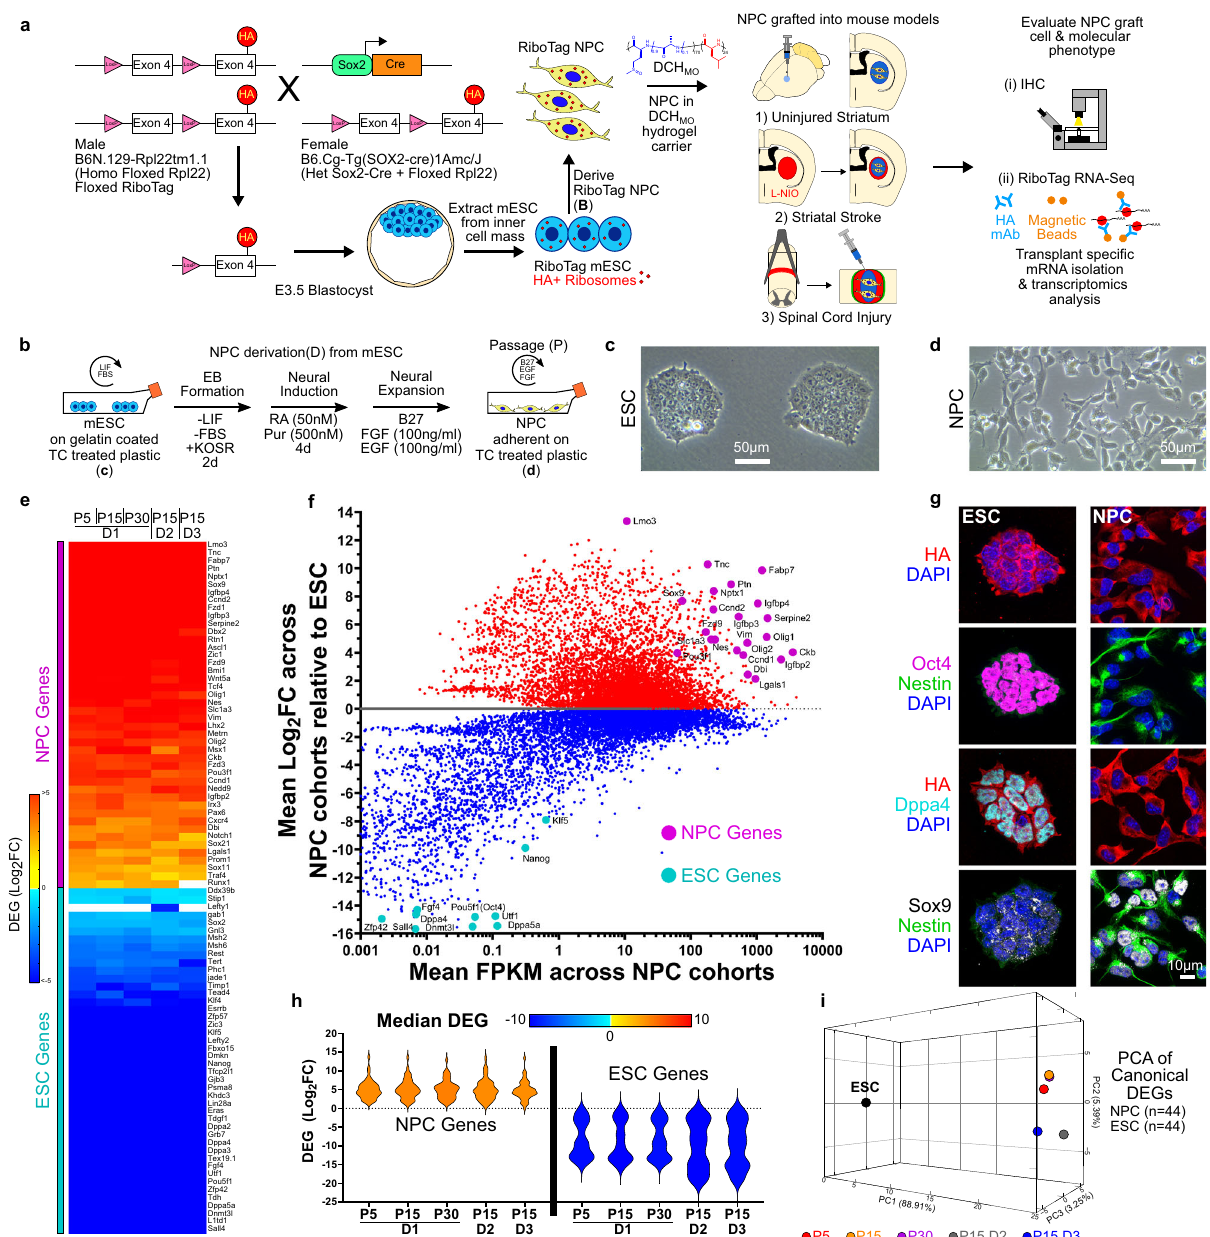
Fig. 1 | Neural induction and expansion ofRiboTag mESC derives reproducible and stable NPC lines. a Schematic of RiboTag ESC derivation by Cre-Lox recom- bination and experimental work fl ow. b Schematic of NPC derivation by sequential neural induction and expansion. c Phase contrast image of ESC colonies. d Phase contrast image of adherent NPC. e Heatmap of DEGs for ESC and NPC gene panels for NPC at different Passages (P) and derivation (D). f M – A Plot of mean tran- scriptome differences averaged across NPC derivations (5 groups, N =4 samples pergroup)referencedtoESC( N =4samples)showingincreasedexpressionofNPC genesanddecreasedexpressionofESCgenes. g ImmunocytochemistryofESCand